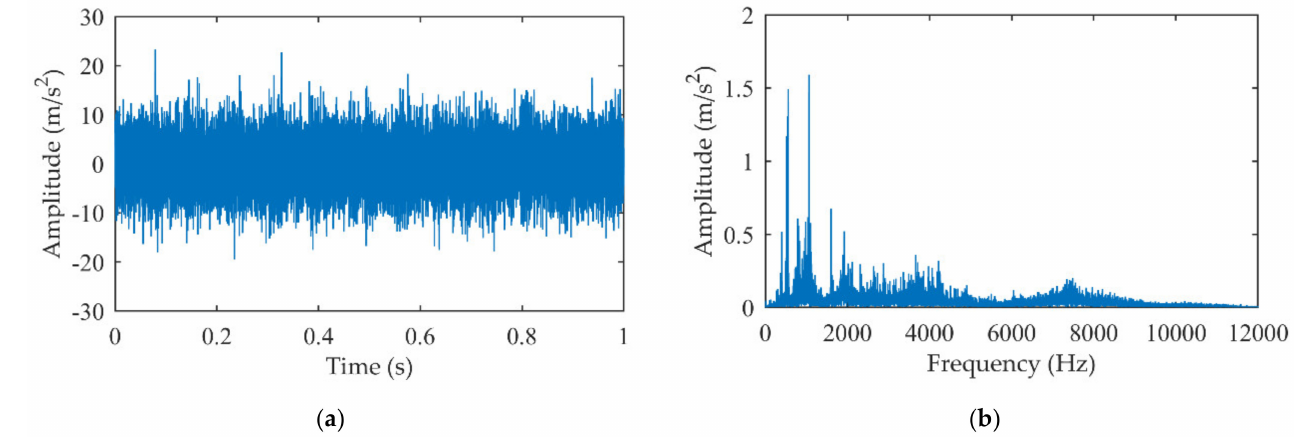
Figure 8. The observed acceleration signal of the single-stage gearbox experiment: ( a ) Time domain signal; ( b ) Amplitude spectrum.